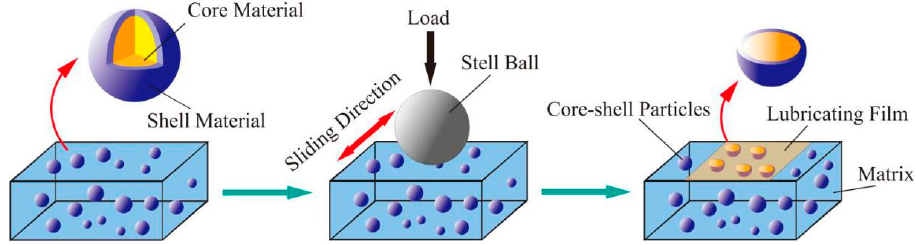
Figure 9. Formation of smooth agent film during sliding wear.